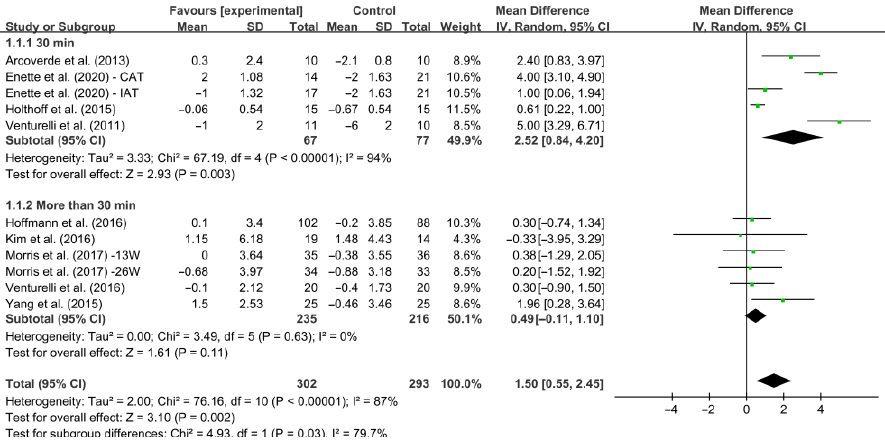
Figure 5. Meta-analysis results of the effect of the duration of intervention per session on cognitive function in AD patients [20,27,39 – 45].